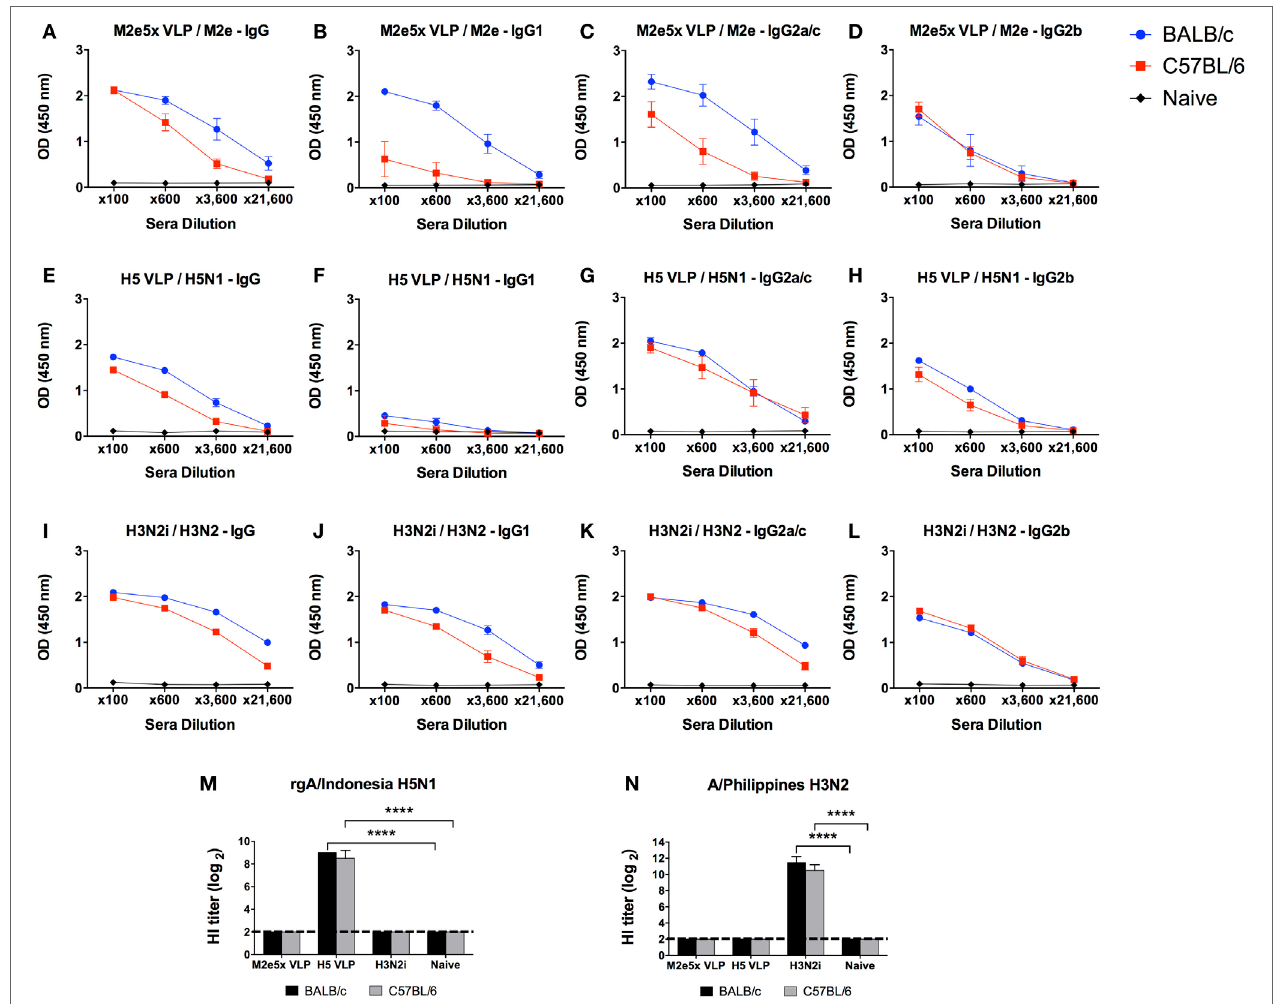
FigUre 1 | IgG isotype antibody responses in BALB/c and C57BL/6 mice after vaccination with different influenza vaccines. Each group of mice ( n = 10) was prime and boost intramuscularly immunized with 10 µg of M2e5x virus-like particle (VLP) (a–D) , H5 hemagglutinin VLP (HA VLP) (e–h) , or inactivated A/Philippines virus (H3N2i) (i–l) . Antibody levels of IgG (a,e,i) , IgG1 (B,F,J) , IgG2a in BALB/c mice or IgG2c in C57BL/6 mice (c,g,K) , and IgG2b (D,h,l) were detected by enzyme-linked immunosorbent assay (ELISA). Sera were serially diluted and ELISA was performed by using vaccine-specific antigens which are M2e peptide, inactivated A/Indonesia (rgH5N1i), and H3N2i. Error bars indicates mean ± SEM. (M,n) Hemagglutination inhibition (HI) titers. HI titers against rgH5N1 (M) and H3N2 (n) were determined from immune sera of M2e5x VLP, H5 HA VLP, or H3N2i. Statistical significances were determined by 2-way ANOVA. **** p <